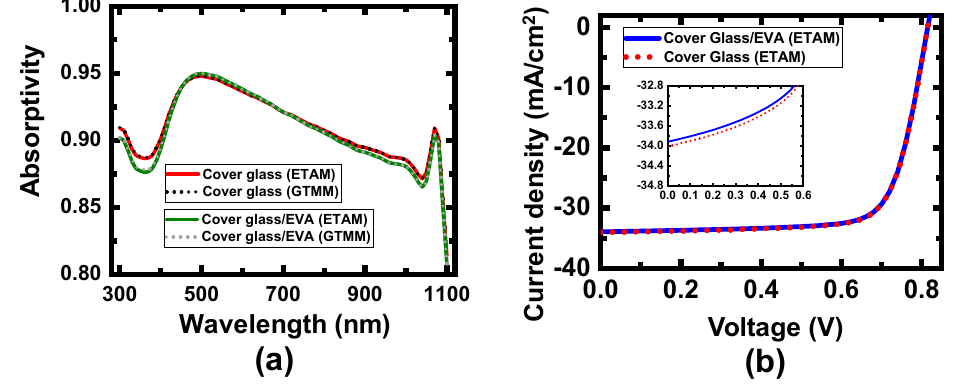
Figure 11. Calculation results of the ETAM-applied ( a ) absorptivity spectra and ( b ) J–V characteristics at the CIGS solar cell having an incoherent layer of only a cover glass (Figure 1) or cover glass/EVA (Figure 10). The absorptivity spectra calculated using the GTMM show a good agreement with the results obtained using the ETAM. The inset shows a close view of the J–V characteristics at near a zero applied